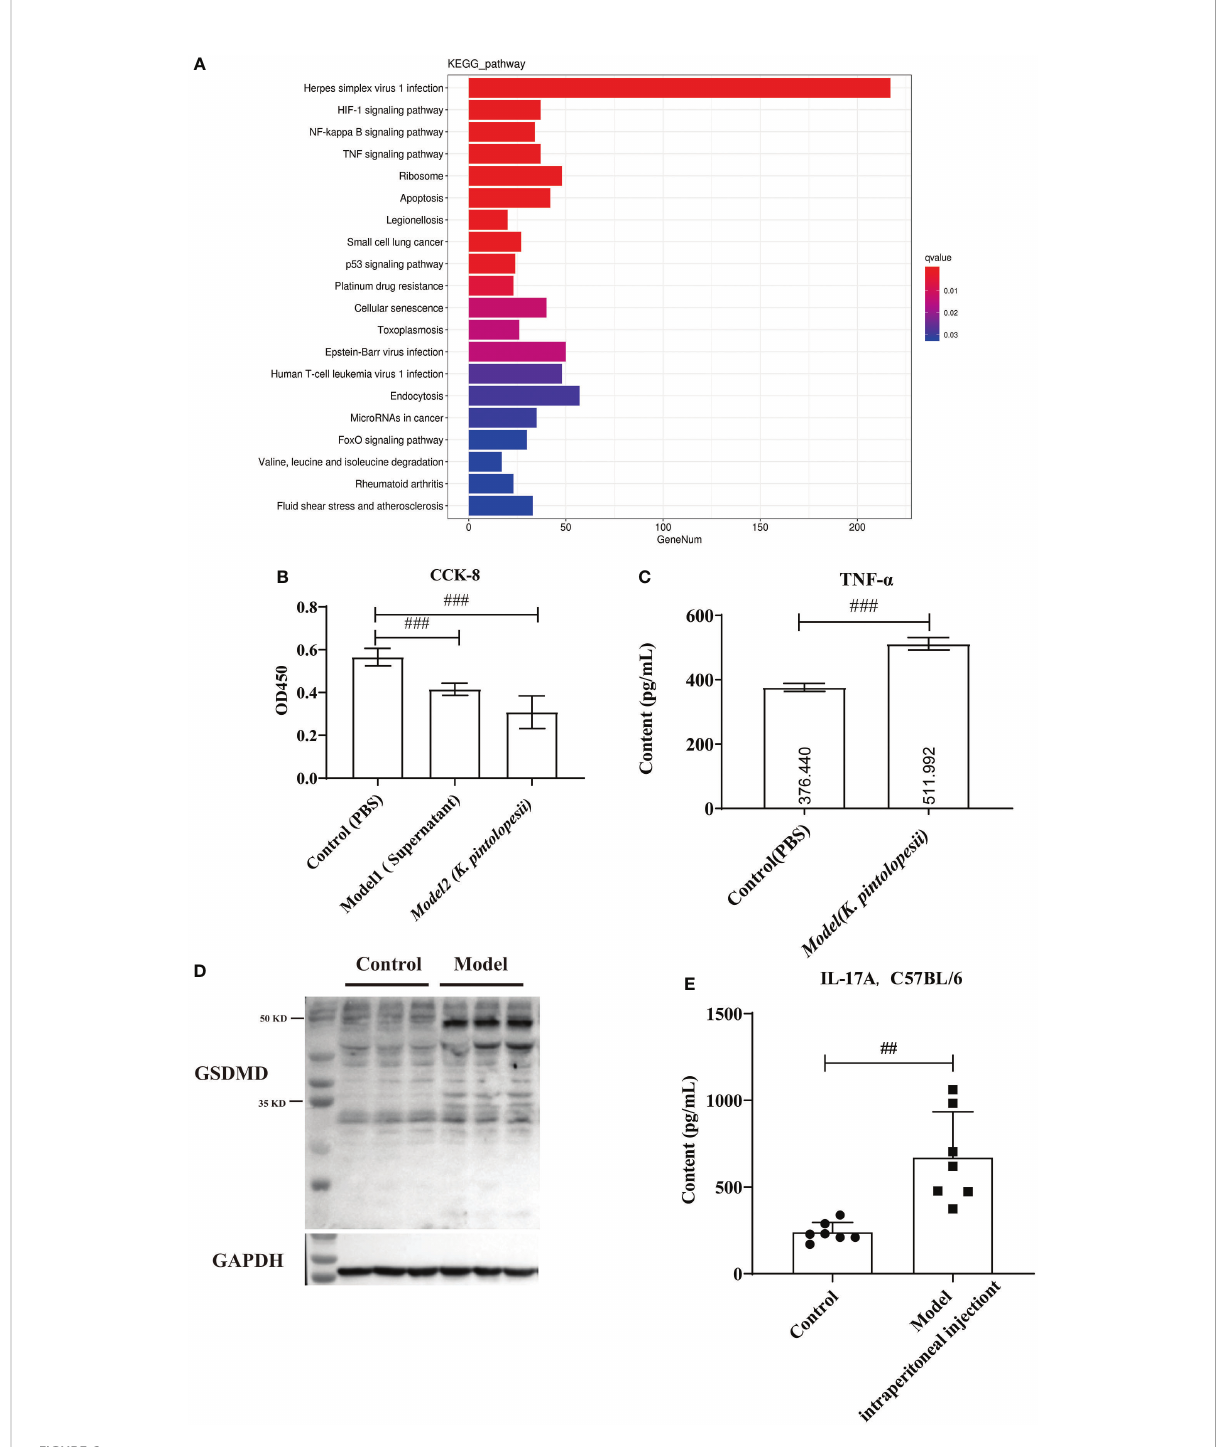
FIGURE 6 The effect of K. pintolopesii on macrophage RAW264.7 (A) KEGG analysis of transcriptome of RAW264.7 treated by K. pintolopesii . (B) CCK8 was used to detect of RAW264.7 treated by the supernatant of K. pintolopesii or K. pintolopesii (C) The content of TNF- a of the supernatant of K. Pintolopesii co-cultured RAW264.7 was determined by Elisa. (D) Western blot was used to detect the GSDMD protein level of RAW264.7 after co-culture with K. pintolopesii . (E) The levels of IL-17A in the serum of mice infected by the products (culture supernatant) secreted by K. pintolopesii through intraperitoneally were determined by Elisa. # p < 0.05, ## p < 0.01, ### p <